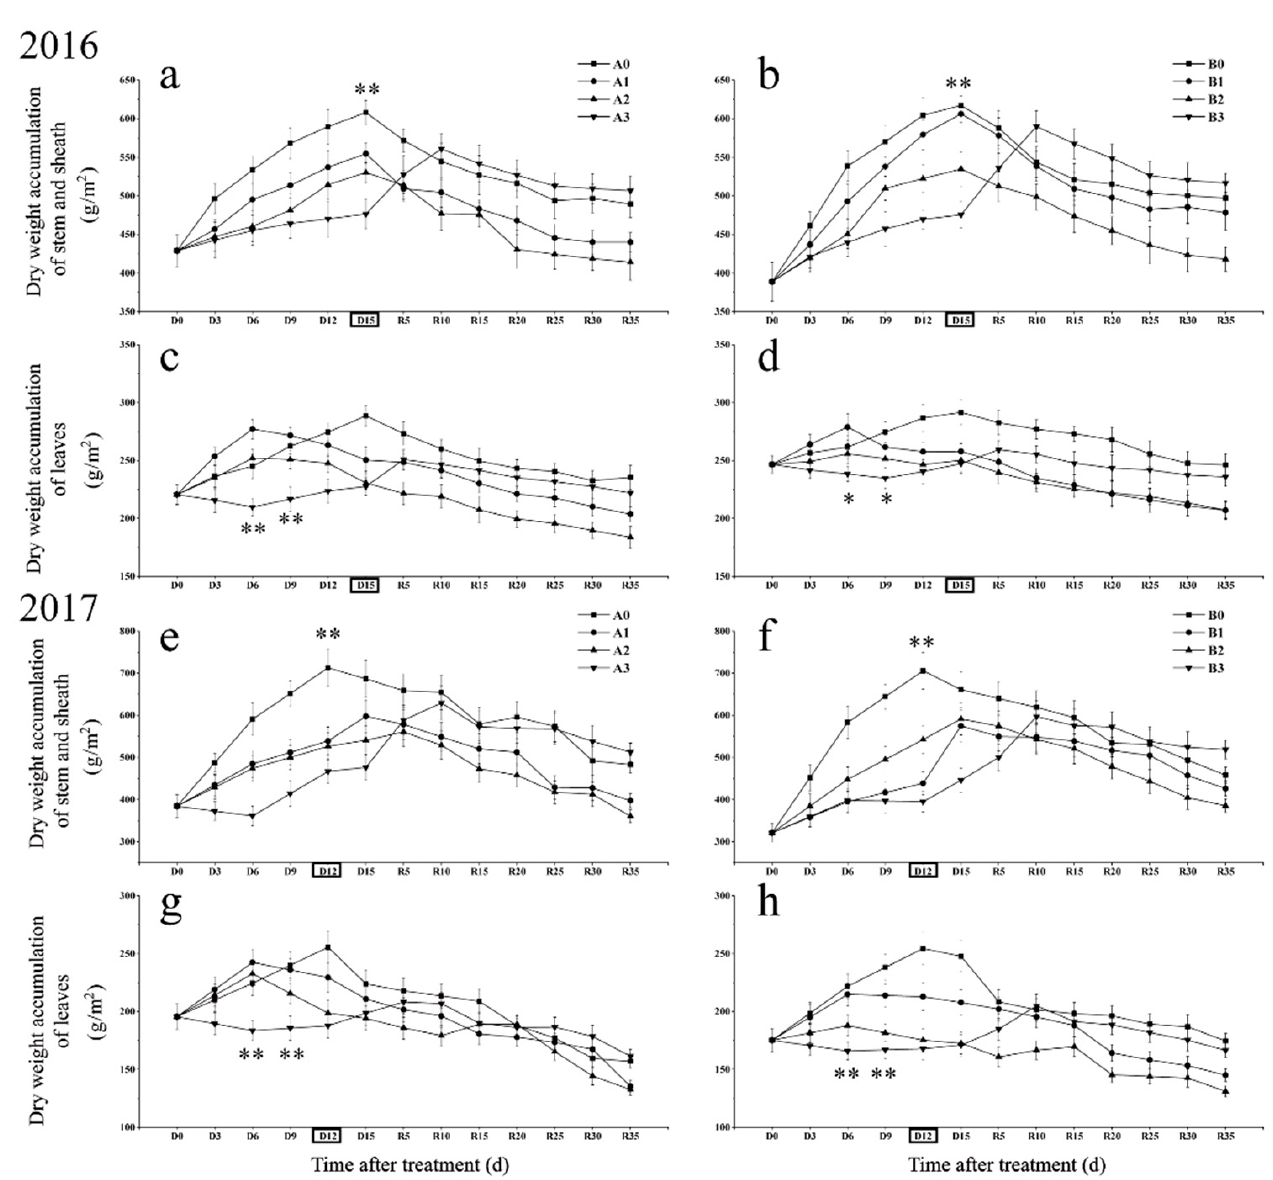
Figure 2. Effects of drought stress at the jointing–booting stage on dry matter accumulation in growth period overlapping rice in 2016 ( a – d ) and 2017 ( e – h ). The full heading stage was D15 days in 2016 and D12 days in 2017. Vertical bars represent standard deviation. A0 and B0, control treatments (0 kPa) of SJ6 and DN425; A1 and B1, mild drought stress treatments ( − 10 kPa); A2 and B2, mild drought stress treatments ( − 25 kPa); A3 and B3, severe drought stress ( − 40 kPa). ** Represent significance at p < 0.01, respectively.